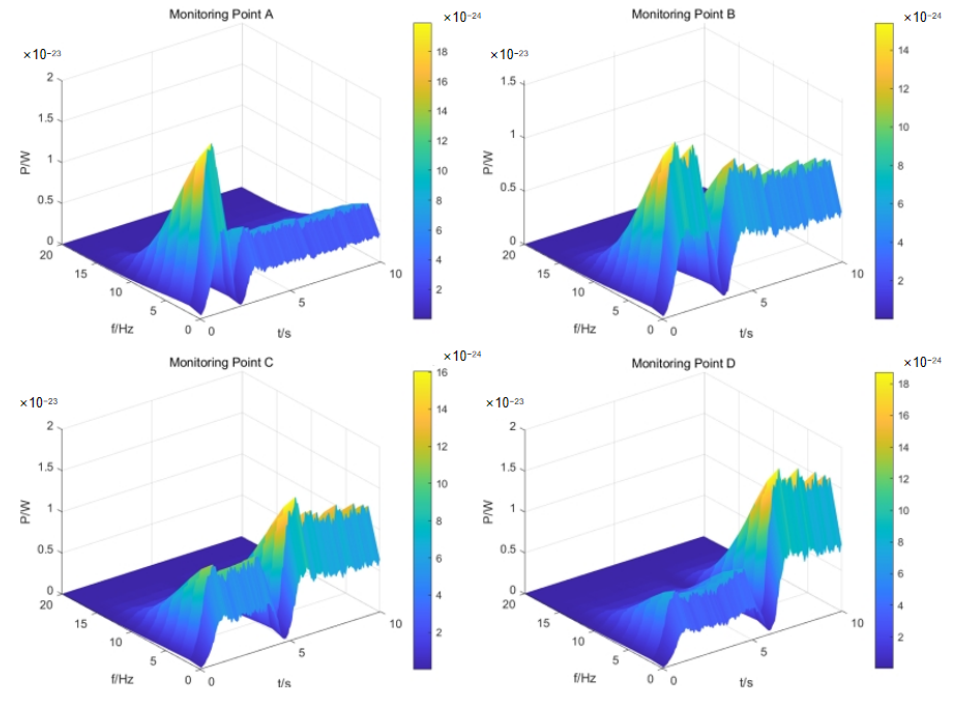
Figure 11. The time-frequency domain diagram of the magnetic field at the monitoring point when the submarine moves at a speed of 3 m/s.